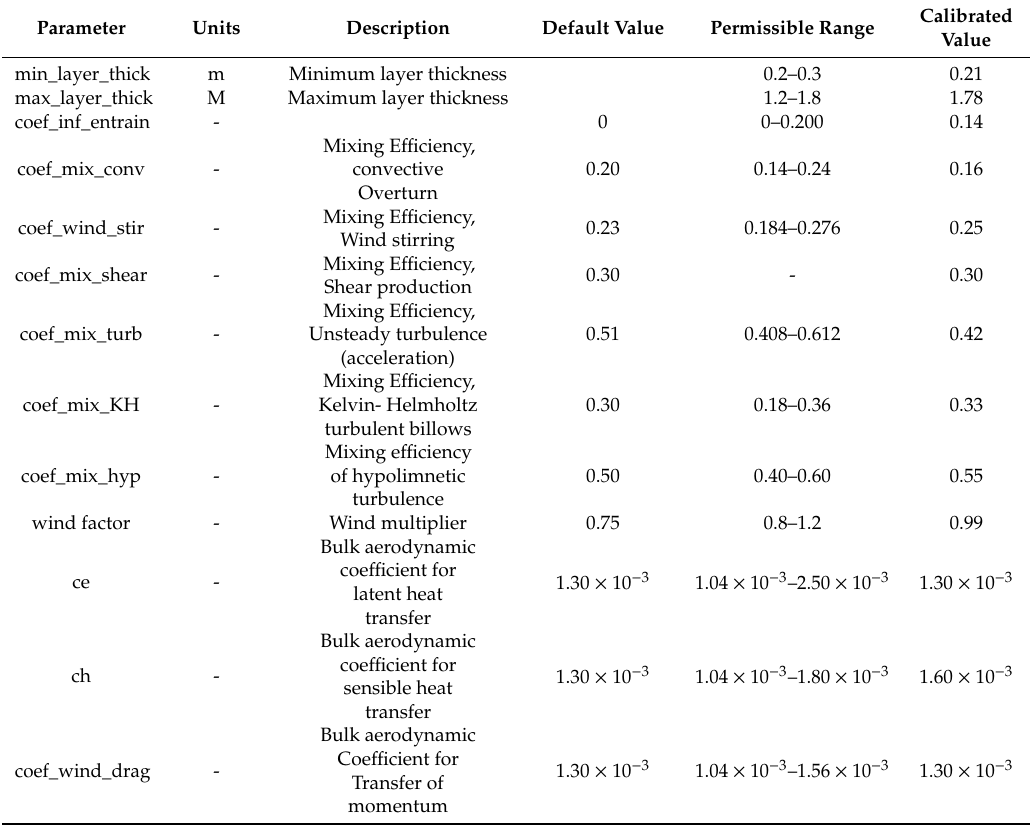
Table1. Generallakemodel(GLM)parameterscalibratedusingthegeneticalgorithm(GA).Thesoftware default values, ranges and final values of those varied in the GA are